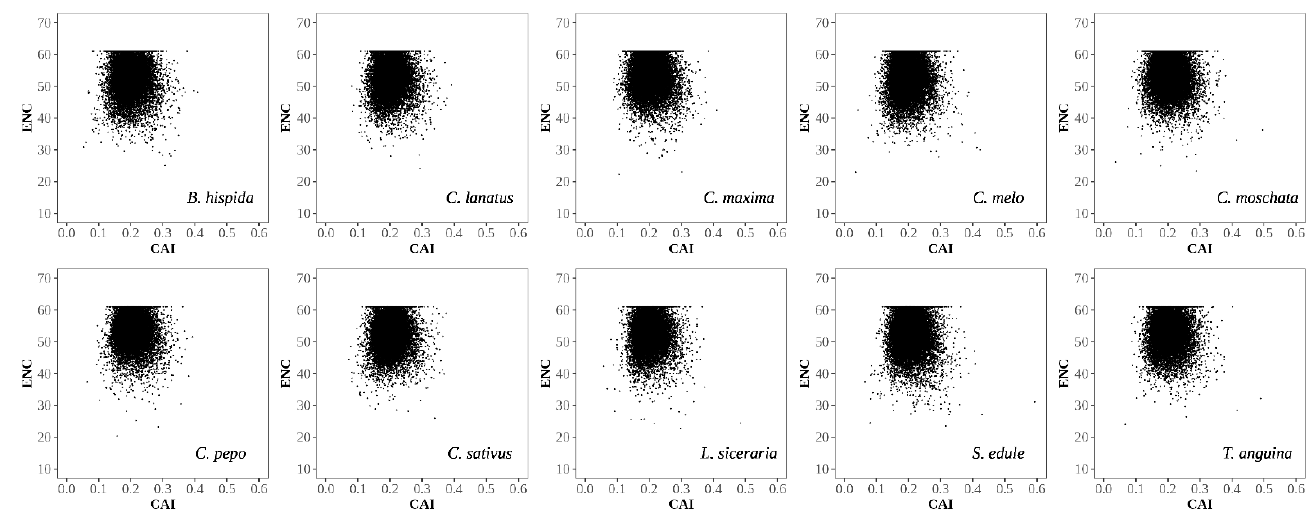
Figure 8. The plot of ENC vs. gene expression level in ten species of Cucurbitaceae. Note: the horizontal axis is the value of CAI; the vertical axis is the value of ENC.